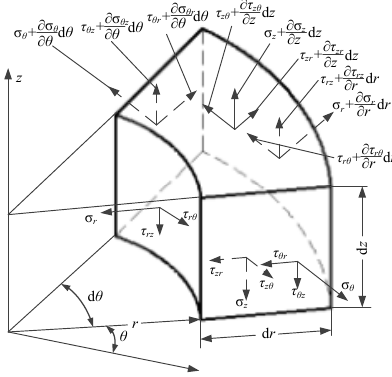
Figure 3. Stress model of an element block in the cylindrical coordinate system.